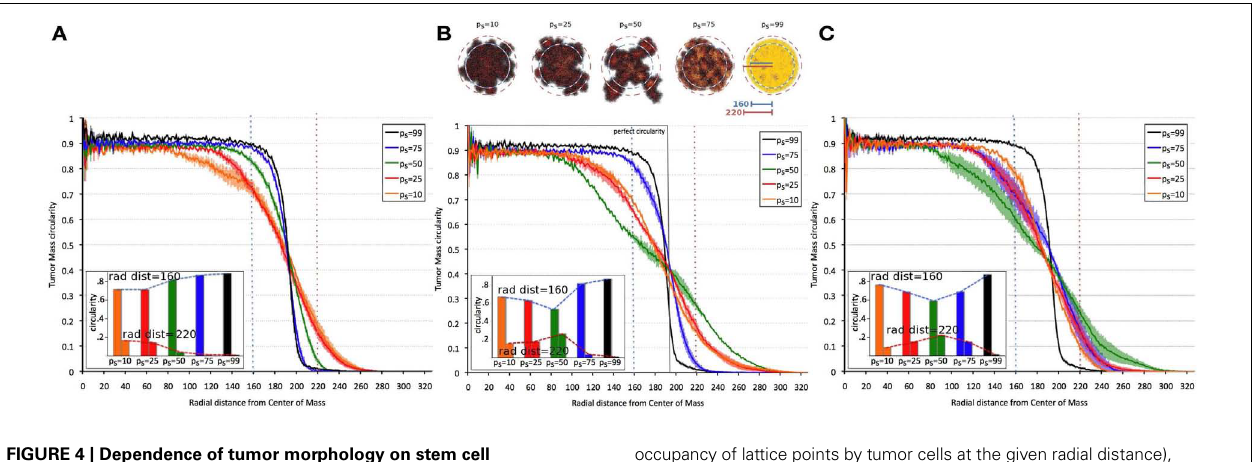
FIGURE 4 | Dependence of tumor morphology on stem cell symmetric division probability and proliferation capacity ρ max = 10 (A), 15 (B), 20 (C). Plotted against radial distance from the center of mass of the tumor is tumor “circularity” (the percent